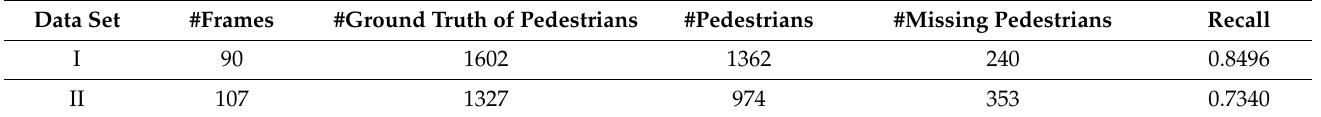
Figure 6. An example of the multiple pedestrian separation process: ( a ) before the separation; ( b ) after the separation. Table 2. Performance of pedestrian candidate detection ( #: count of pedestrians).